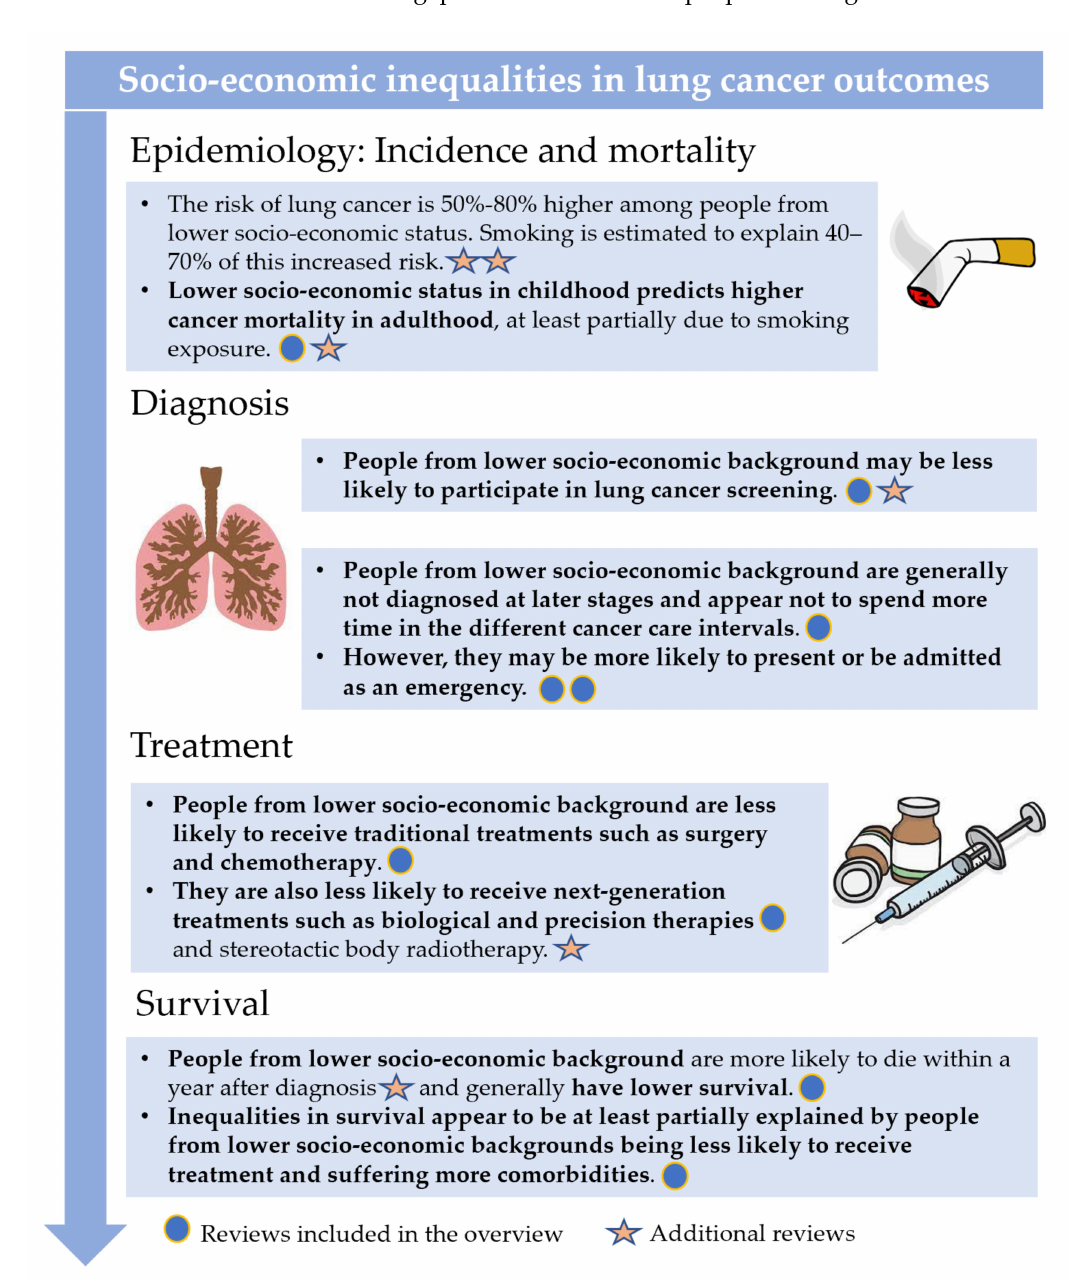
Figure 3. Summary of the available evidence about socio-economic inequality in lung cancer out- comes. Circles denote articles included in the overview of systematic reviews [6,10,11,17,19,28,31,32] and stars denote additional reviews